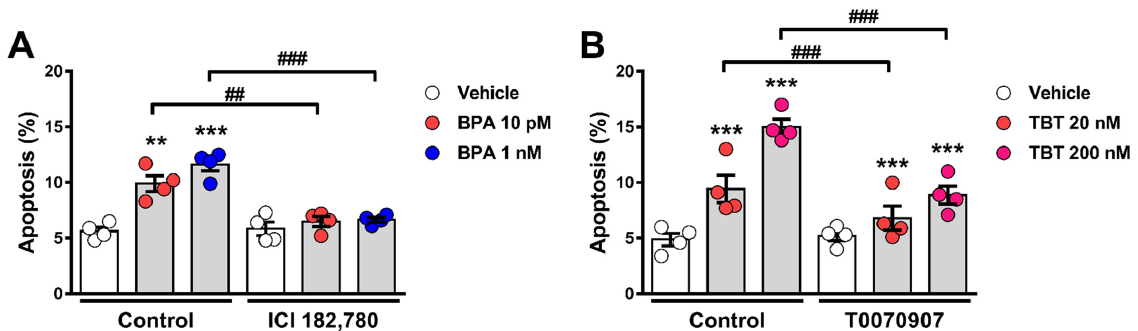
Figure 2. Estrogen receptors and PPAR γ are implicated in BPA- and TBT-induced α -cell apoptosis, respectively . ( A ) α TC1-9 cells were treated with vehicle (DMSO) or BPA (10 pM or 1 nM) in the absence (control) or presence of 1 µM ICI 182,780 for 24 h. ( B ) α TC1-9 cells were treated with vehicle (DMSO) or TBT (20 nM or 200 nM) in the absence (control) or presence of 100 nM T0070907 for 24 h. Apoptosis was evaluated using HO and PI staining. Data are shown as means ± SEM (n = 4 inde- pendent experiments, where each dot represents an independent experiment). ** p ≤ 0.01 and *** p ≤ 0.001 vs. its respective vehicle; ## p ≤ 0.01 and ### p ≤ 0.001 as indicated by bars. Two-way